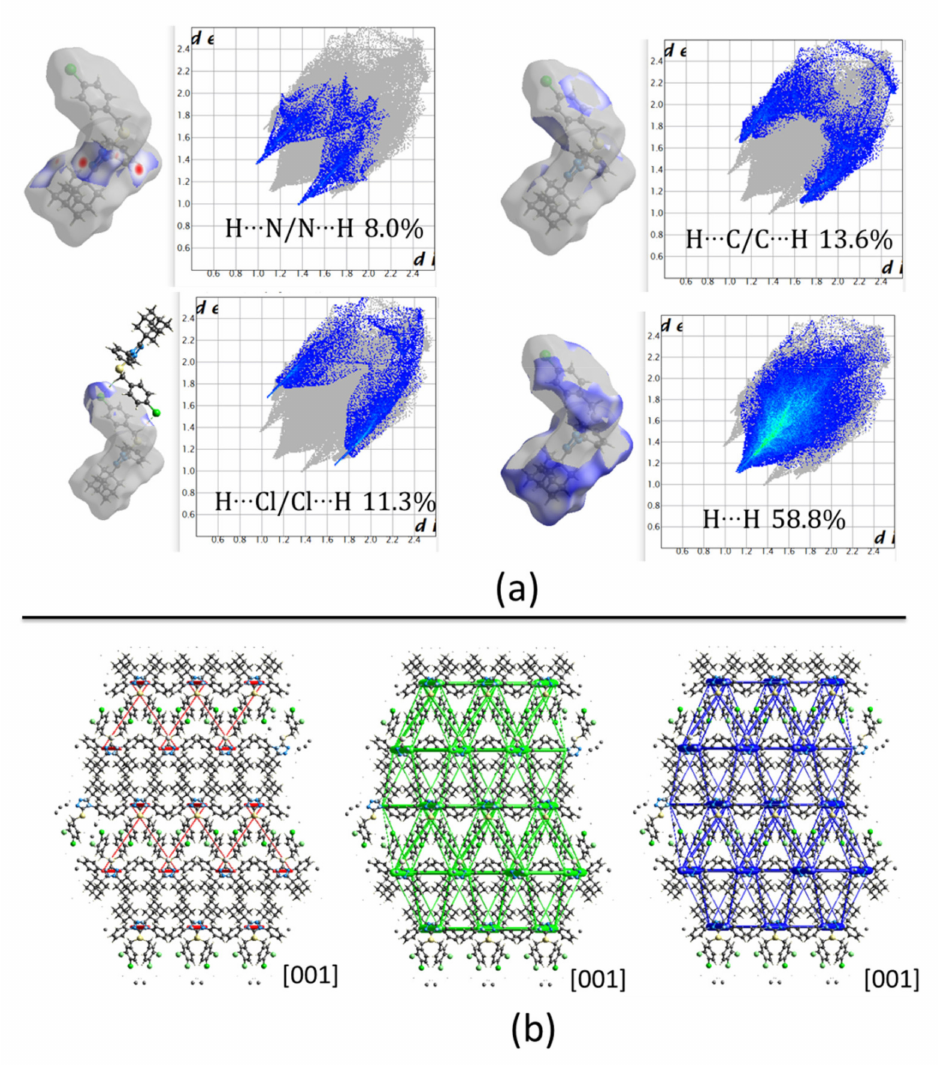
Figure 8. ( a ) Hirshfeld surfaces mapped over d norm and the two-dimensional fingerprint plots, ( b ) Energy framework diagrams for electrostatic (red) and dispersion (green) contributions to the total interaction energies (blue) in compound 3